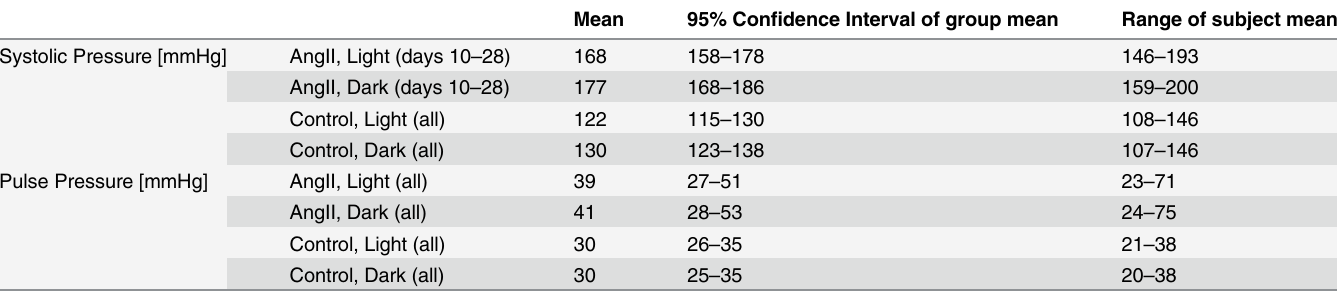
Table 1. Descriptive Statistics for Telemetry Blood Pressure Measurements over